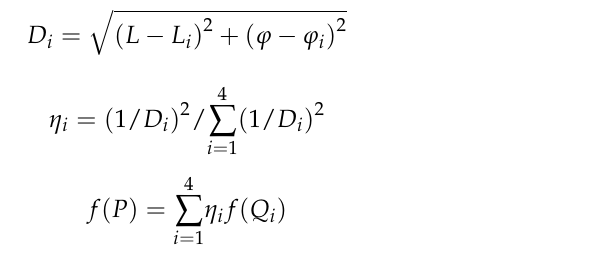
Figure 4. The process of the ZTD integration method for reanalysis data.